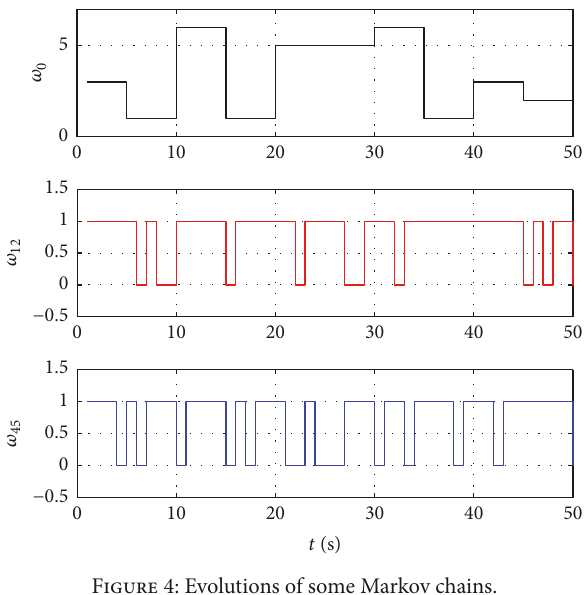
Figure 4: Evolutions of some Markov